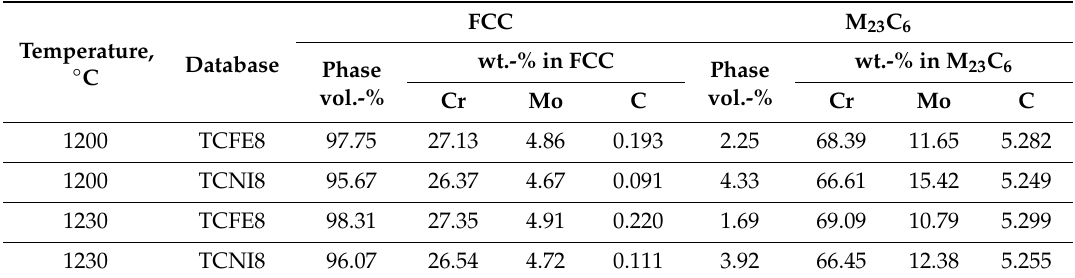
Table 4. Equilibrium compositions and volume fractions of the FCC and M23C6 at 1200 ◦ C and 1230 ◦ C.